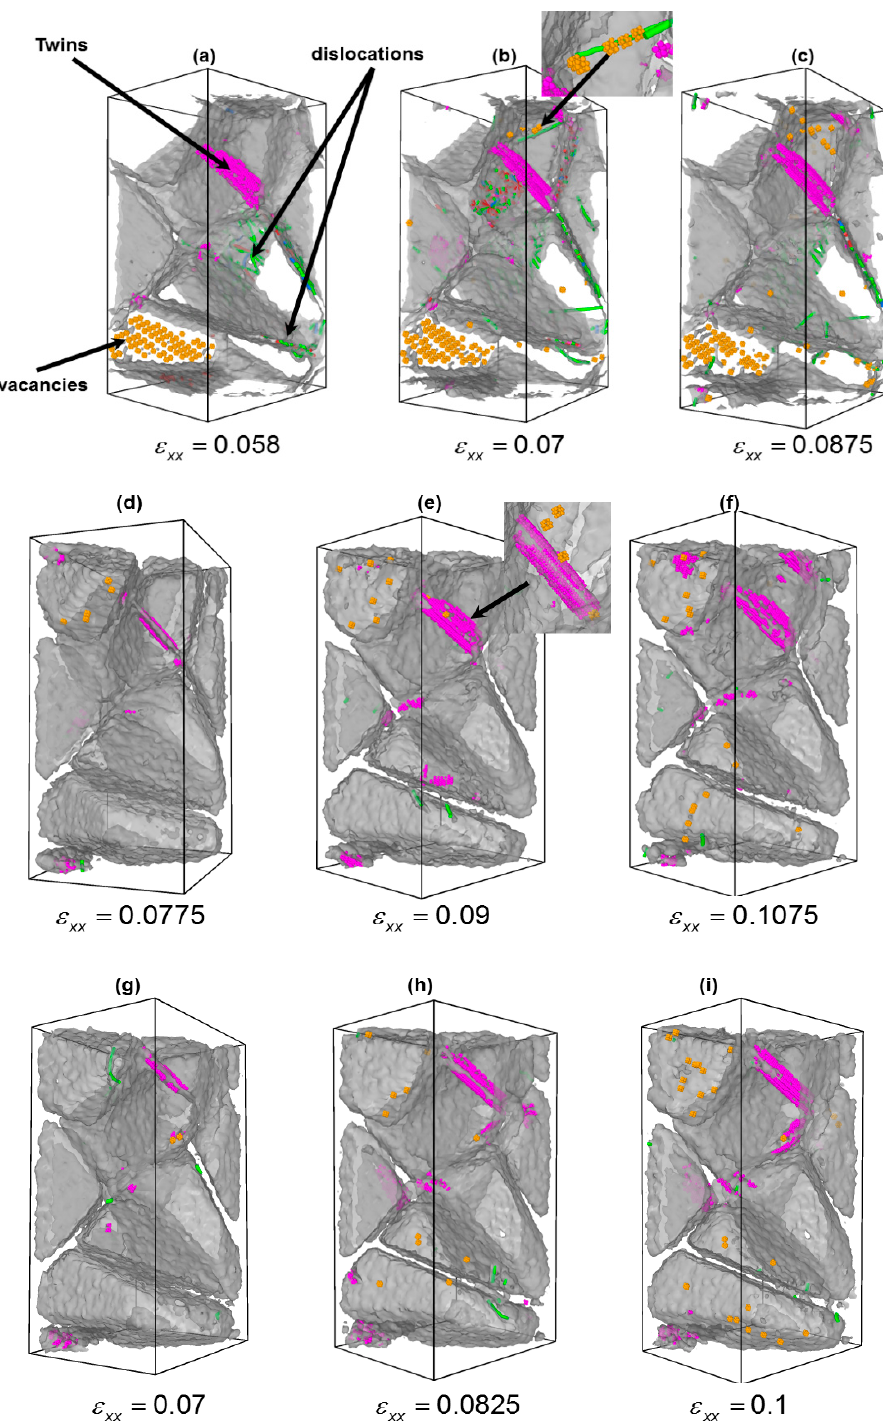
Figure 9. MD snapshots showing the evolution of various deformation mechanisms observed during tensile test of nc Fe (upper panel), nc-Fe-C (middle panel), and nc-Fe-N (lower panel) at different strains. (For interpretation of the references to color in this figure, the reader is referred to the web version of this article). green, purple and orange colors denote dislocation, twins and vacancy clusters, respectively. ( a – i ) represents the microstructural evolution under applied strain .